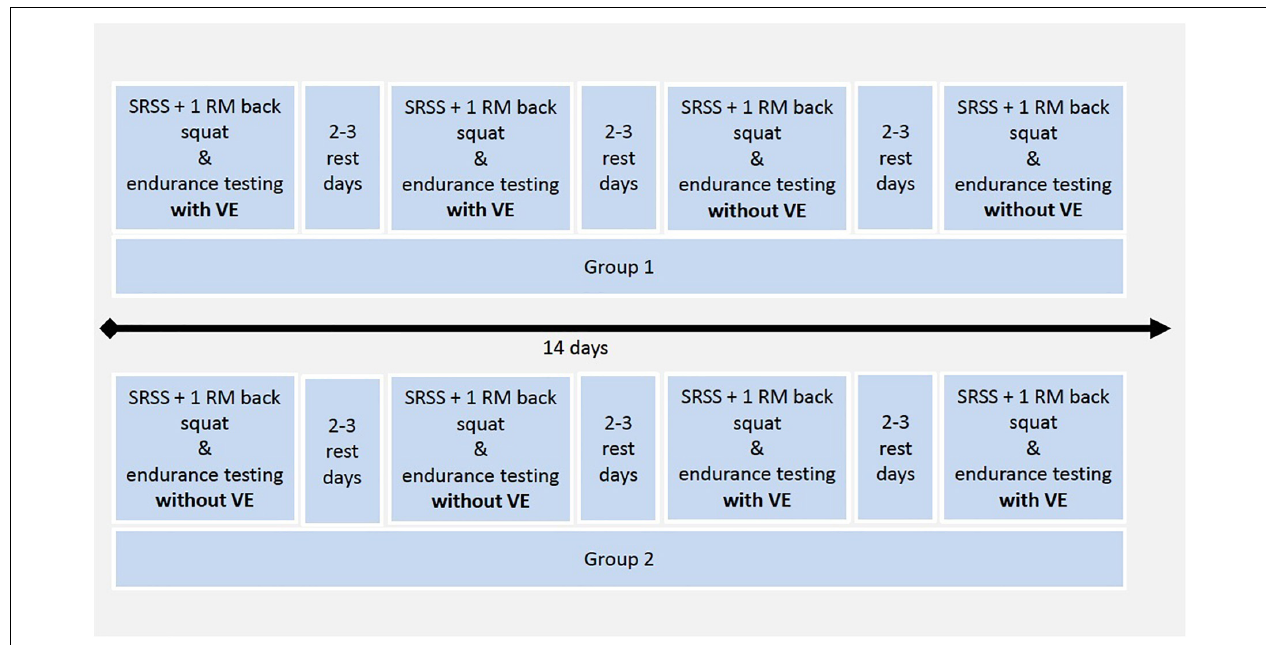
FIGURE 1 | Visualization of the block randomized controlled cross-over design during 14 days. Notes : 1 RM, one repetition maximum. SRSS, Short Recovery and Stress Scale. VE, verbal